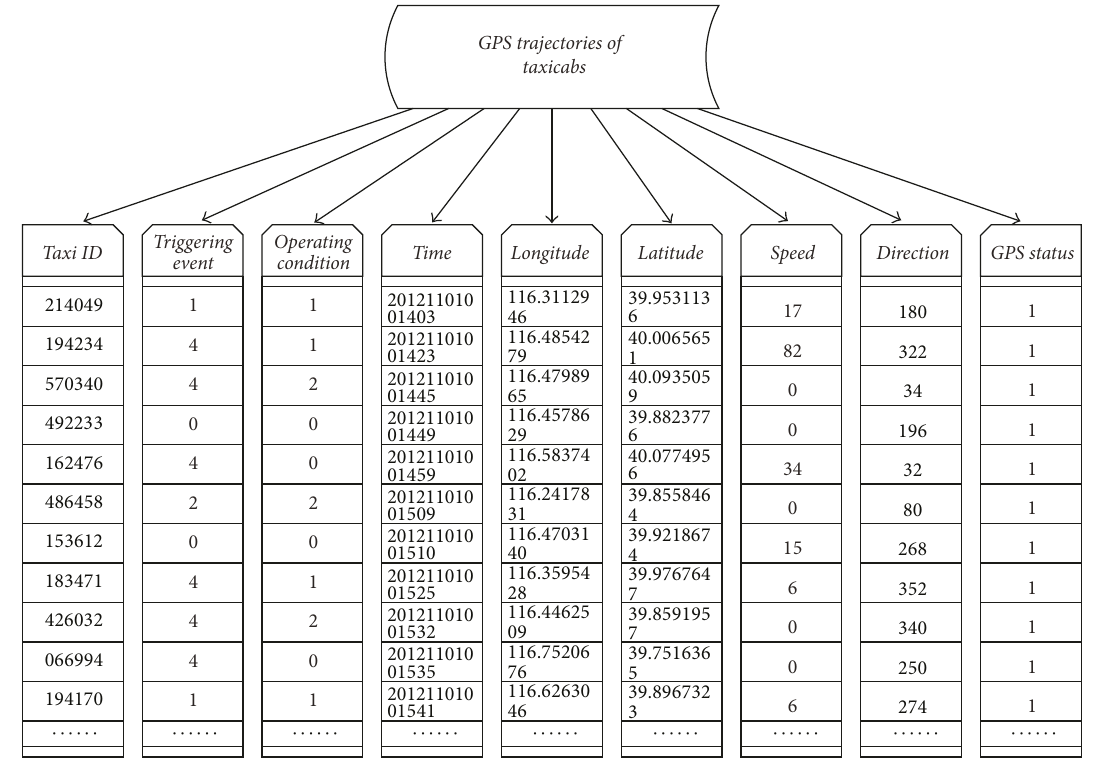
Figure 3: The data sample of large-scale taxi trajectories. Table 1: Association rules in the spatial